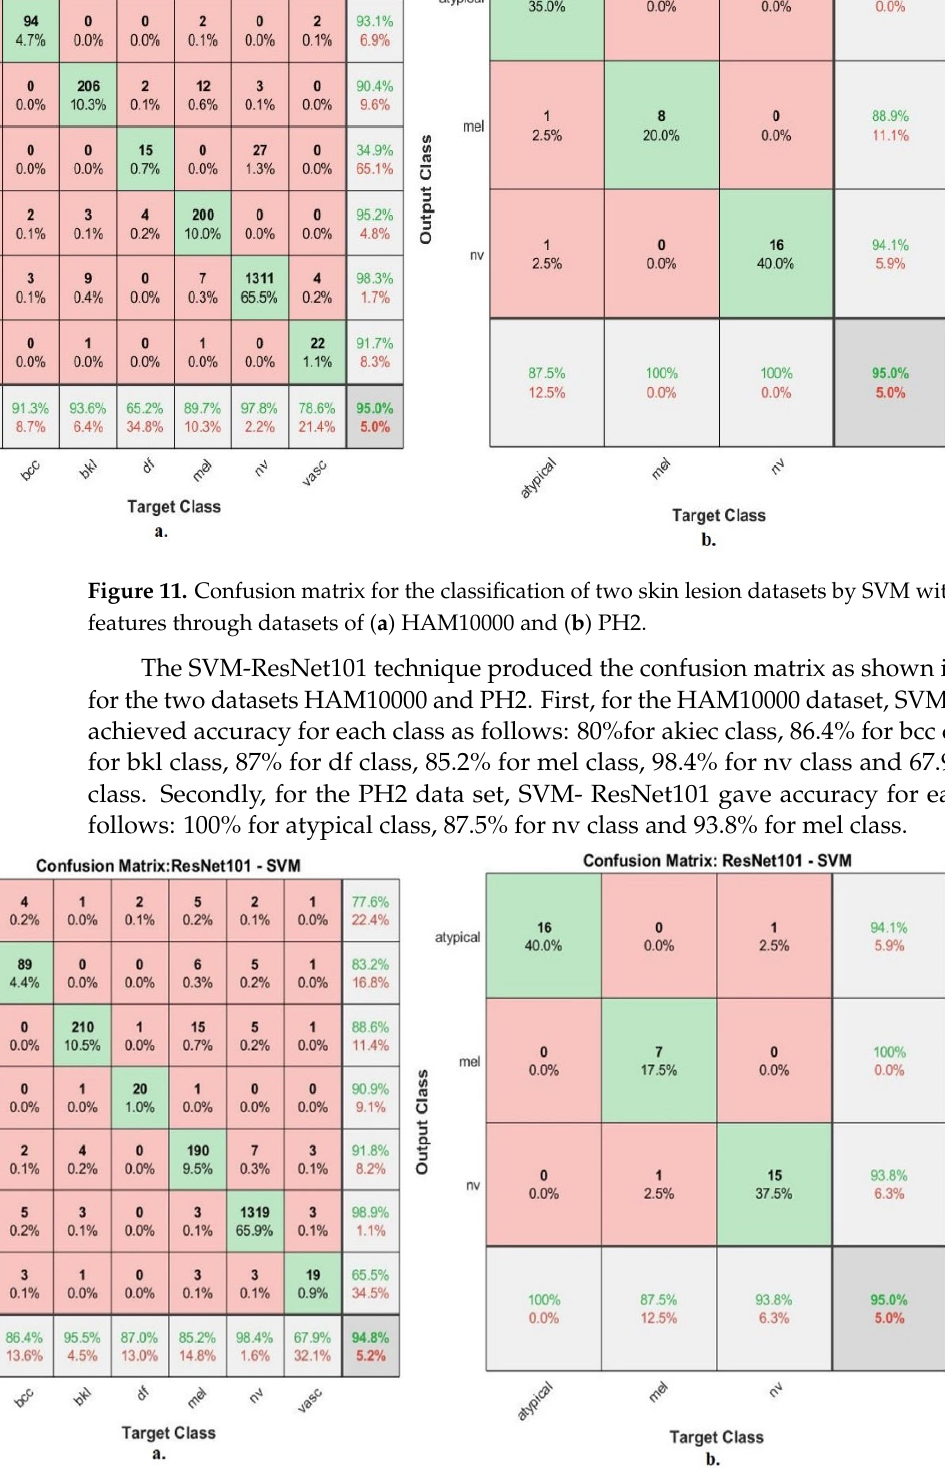
Figure 12. Confusion matrix for the classification of two skin lesion datasets by SVM with ResNet101 features through datasets of ( a ) HAM10000 and ( b ) PH2.